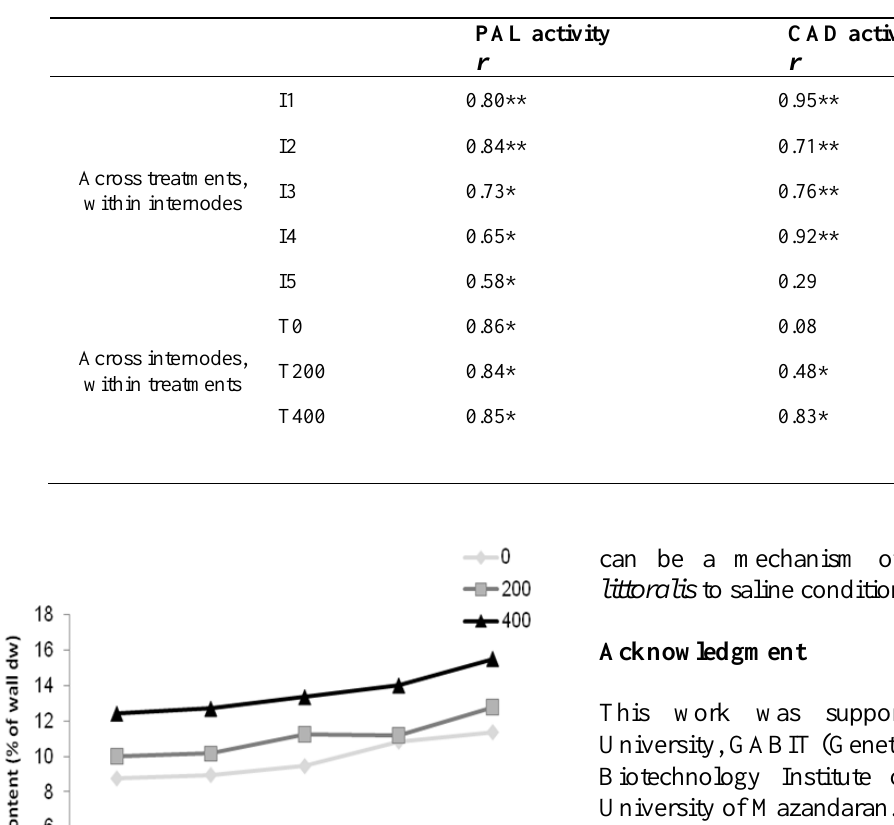
Table 1. Correlation of lignin content with PAL and CAD activity: I1- I5: Internode number from top. T: NaCl Treatmeant; 0, 200 and 400 mM NaCl. r = correlation coefficient, * p < 0.05; ** p < 0.01